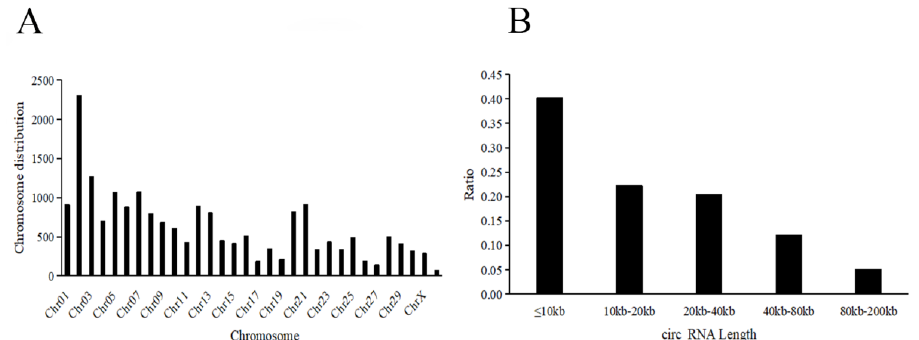
Figure 1. General characteristics of circRNAs in donkey testis and caput epididymis: ( A ) chromo- somal distribution of circRNAs; ( B ) length distribution of circRNAs.